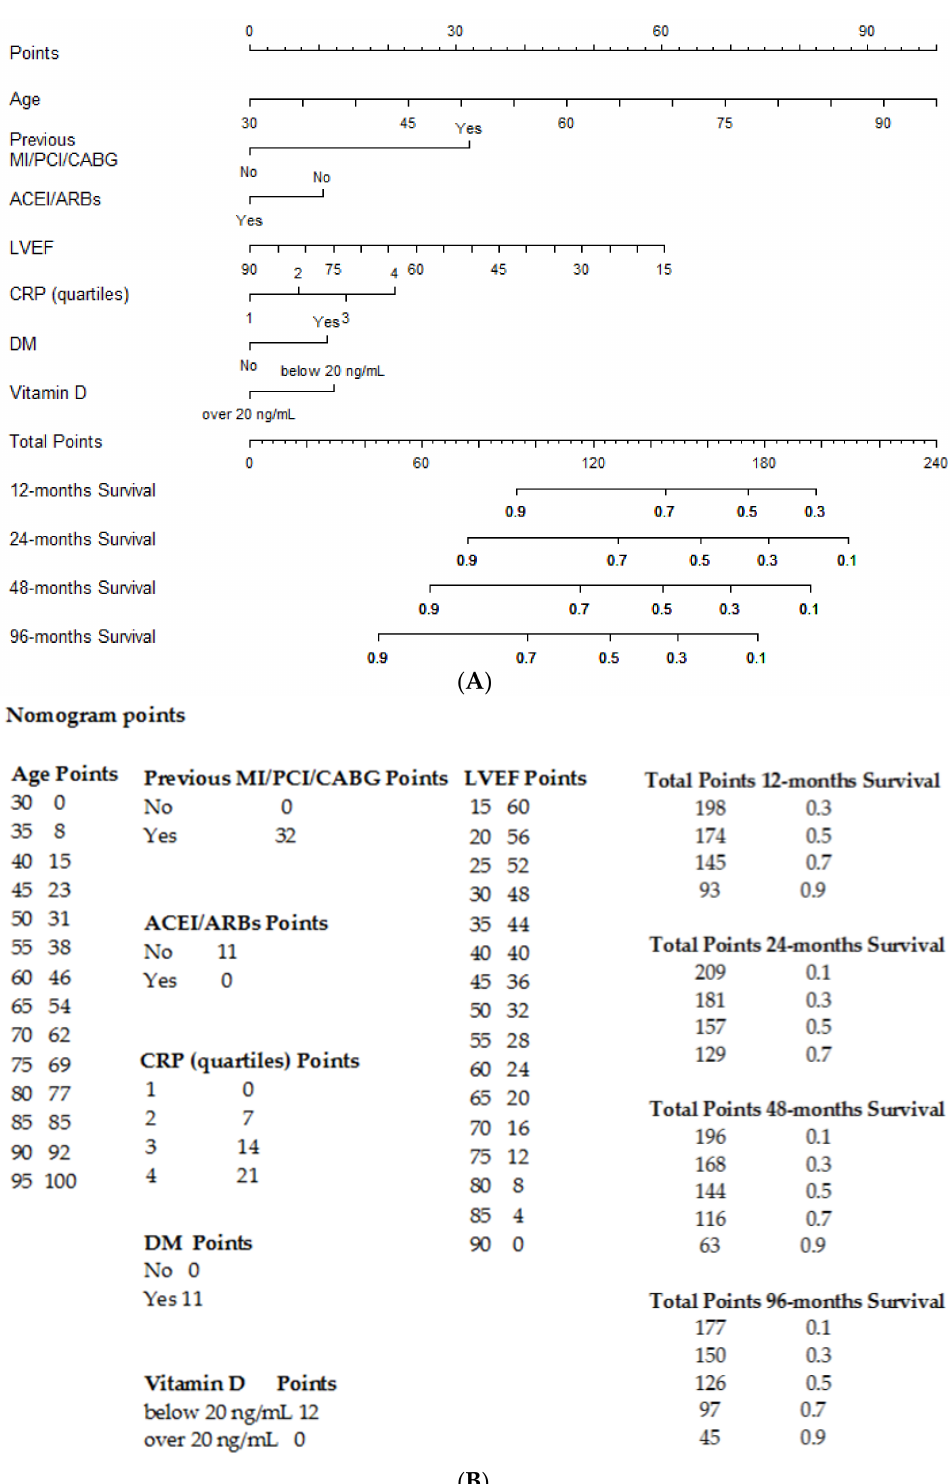
Figure 2. Outcome prediction. ( A ) . Nomogram for outcome prediction. ( B ). Clinical individual variables values (derived from the nomogram) and relative score used to predict the likelihood of the composite end-point risk at 12, 24, 48 and 96 months. Legend: MI: myocardial infarction; PCI: percutaneous coronary intervention; CABG: coronary artery bypass grafting; LVEF: left ventricular ejection fraction; CRP: C-reactive protein; ACEIs/ARBs: angiotensin converting enzyme inhibitors/angiotensin receptor blockers; DM: diabetes mellitus.